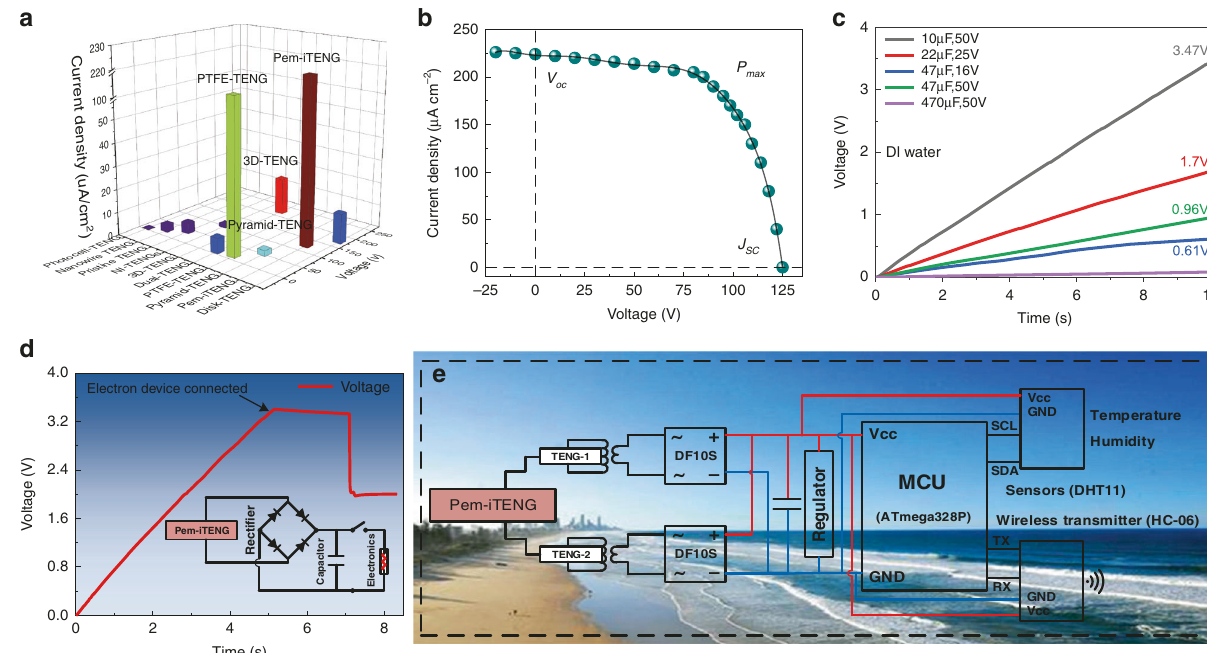
Fig. 6 Power conversion ef fi ciency and application of Pem-iTENG. a Comparison of electrical performance between Pem-iTENG and reported solid-liquid contact based TENGs. b Current density-voltage ( J-V ) curve of Pem-iTENG under solar light intensity and tidal waves. c Voltage curves of charging fi ve commercial capacitors using Pem-iTENG, respectively. d Charging curve for a 0.47 μ F capacitor. e Schematic diagram of the circuit of a self-powered wireless environmental monitoring